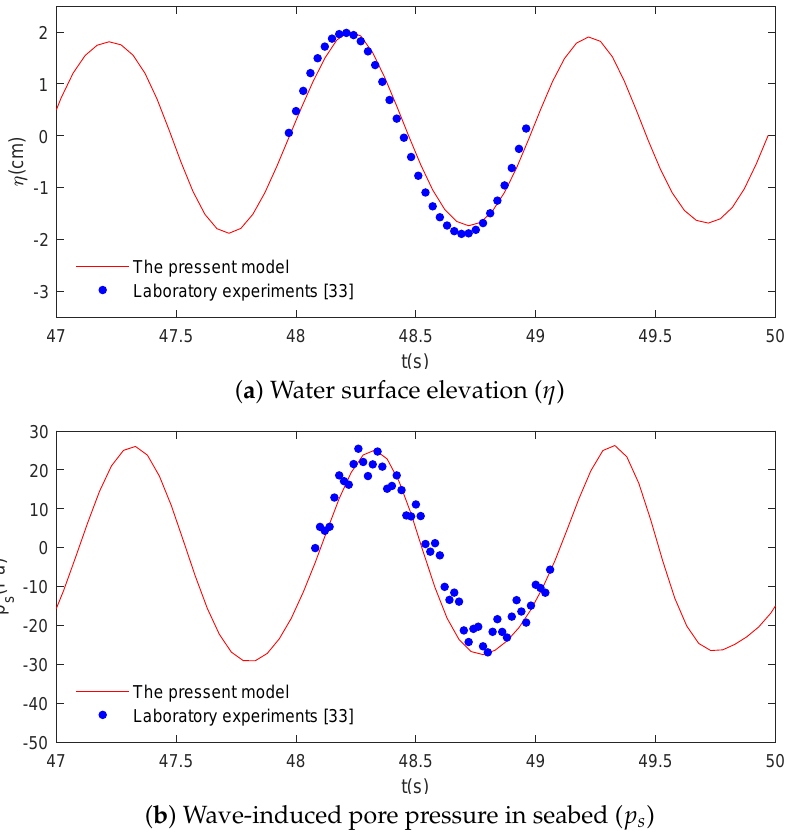
Figure 3. Validation of the present model with the experimental data [33] (wave only): ( a ) water surface elevation ( η ) and ( b ) the wave-induced pore pressure in seabed ( p s ). Input data: wave height ( H ) = 5 cm, wave period ( T ) = 1 s, water depth ( d ) = 50 cm, seabed thickness ( h ) = 50 cm, degree of saturation ( S r ) = 1, Shear modulus ( G ) = 10 7 N/m 2 , Poisson’s ratio ( µ ) = 0.3, soil permeability ( K s ) = 1.88 × 10 − 4 m/s, and soil porosity ( n s ) =